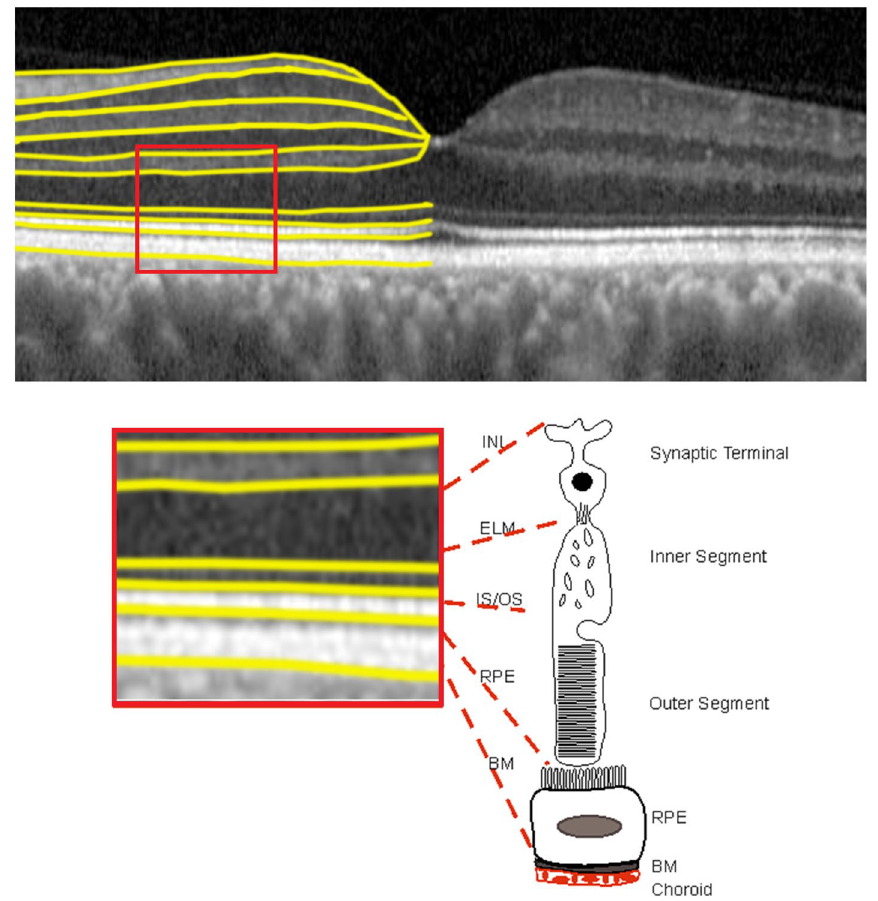
Figure 1. Optical coherence tomography with segmentation in half the image and a schematic demonstrating corresponding outer retinal layers in relation to photoreceptor segments and retinal pigment epithelium. Inner nuclear layer- External limiting membrane (INL-ELM) representative of the synaptic terminal. External limiting membrane—Inner and outer segments (ELM-ISOS) representative of the photoreceptor inner segment. Inner and outer segments—Retinal pigment epithelial thickness (ISOS-RPE), representative of the photoreceptor outer segment. Retinal pigment epithelium—ruch’s membrane (RPE-BM) representative of the RPE and BM